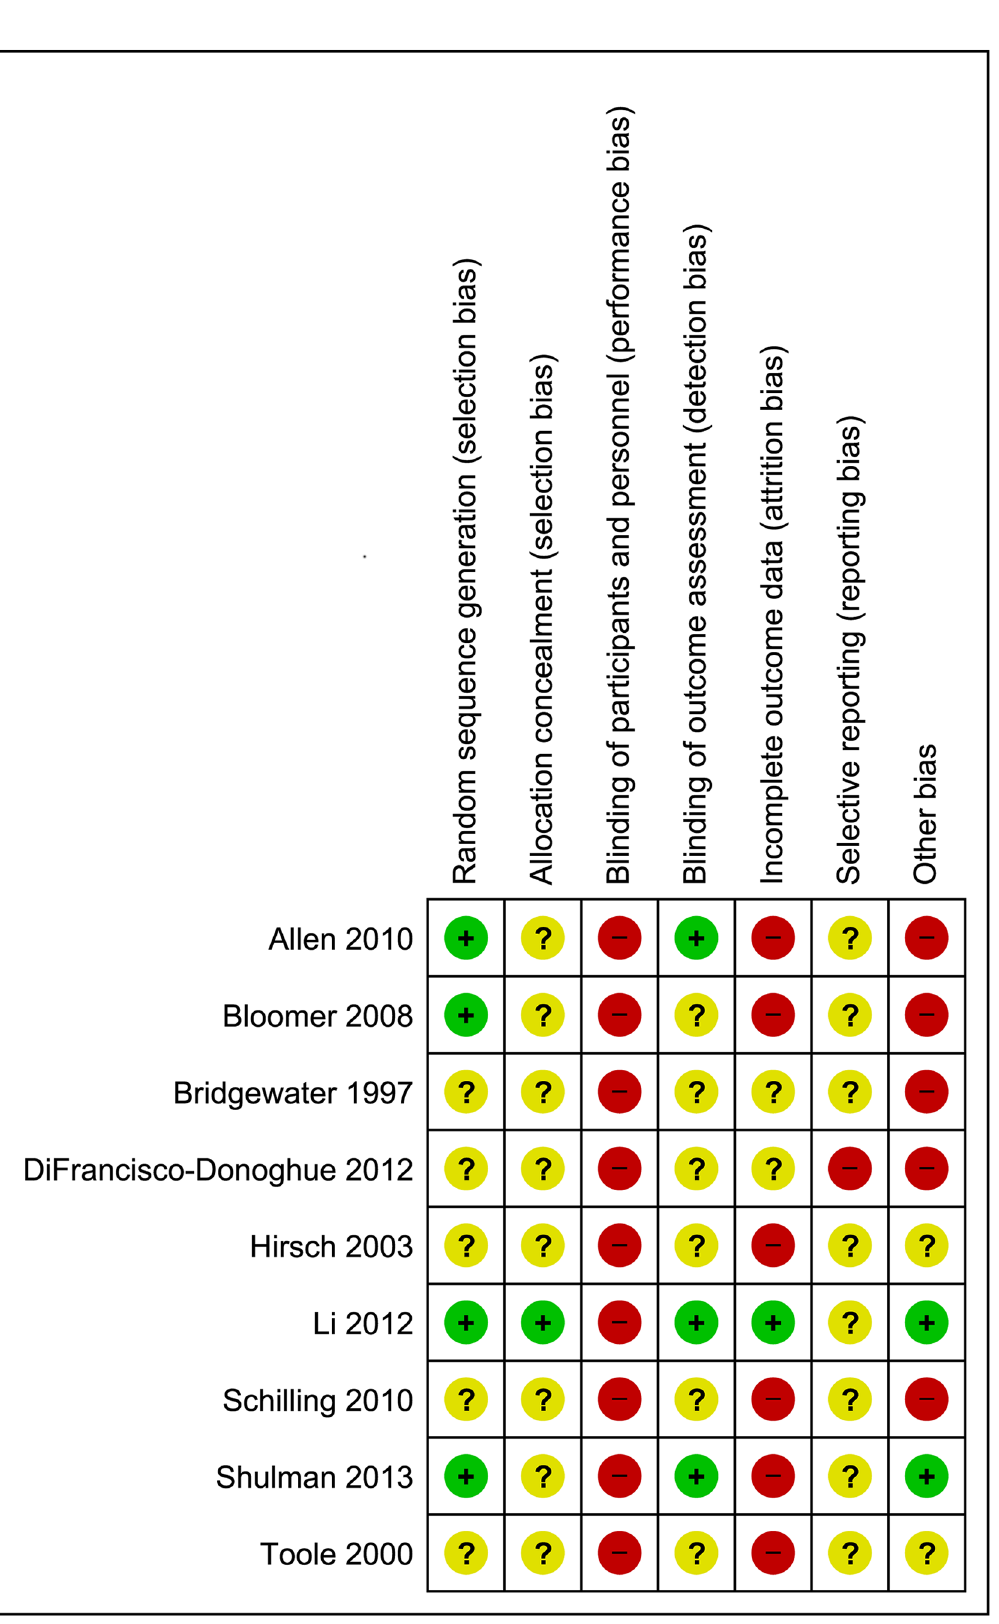
Fig 2. Risk of bias summary: review authors' judgements about each risk of bias item for each included study. doi:10.1371/journal.pone.0132135.g002 PLOS ONE | DOI:10.1371/journal.pone.0132135 July 6,